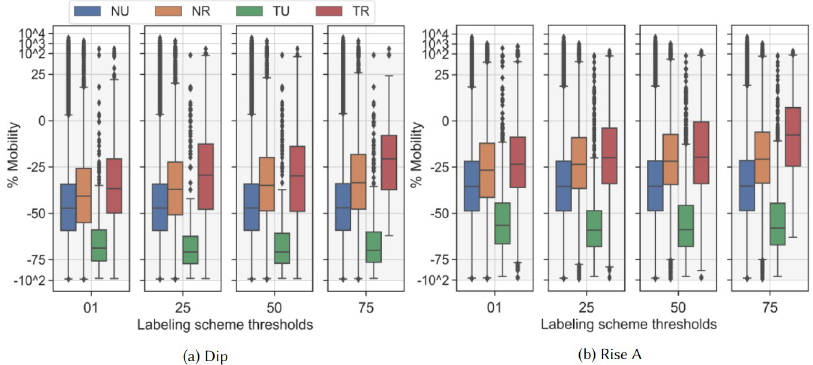
Fig 7. SoCal mobility in categories from different threshold labeling schemes directly following the March 19 SAH. We here use a symmetric logarithm scale to allow positive and negative outliers to be visible while presenting the central values within the shaded linear range (-85, 45). Box extents show the 25 th to 75 th percentiles, and whiskers show 5 th and 95 th . The linear range was chosen to cover the entire whisker extent of all clusters, while allowing outliers to be plotted logarithmically. A comparison of medians across thresholds and categories is shown in Table 2. We explore the relative ranges of mobilities in each cluster across thresholds. The important takeaway is that all labeling thresholds produce similar relative relationships between mobility ranges of clusters, indicating we can expect to see consistent trends between clusters no matter which threshold we choose for analysis.